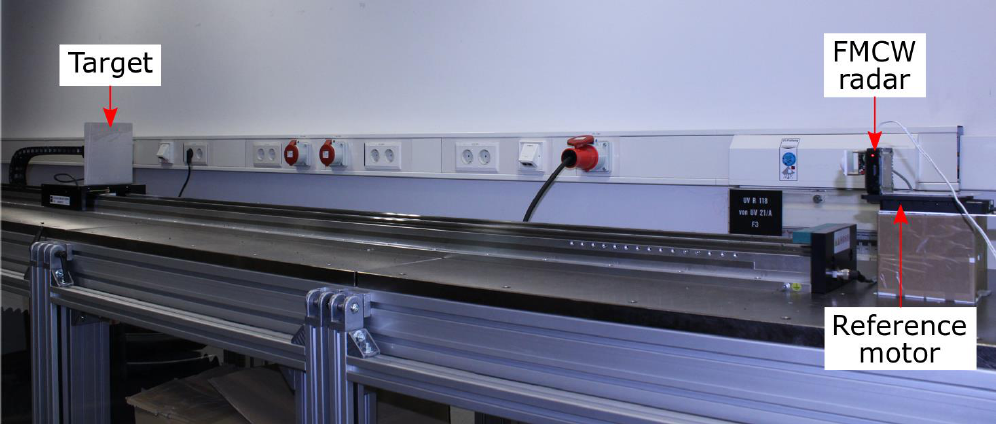
Sensors 2019 , 19 , x FOR PEER REVIEW Figure 5. High-accuracy distance measurement setup . Figure 5. High-accuracy distance measurement setup.